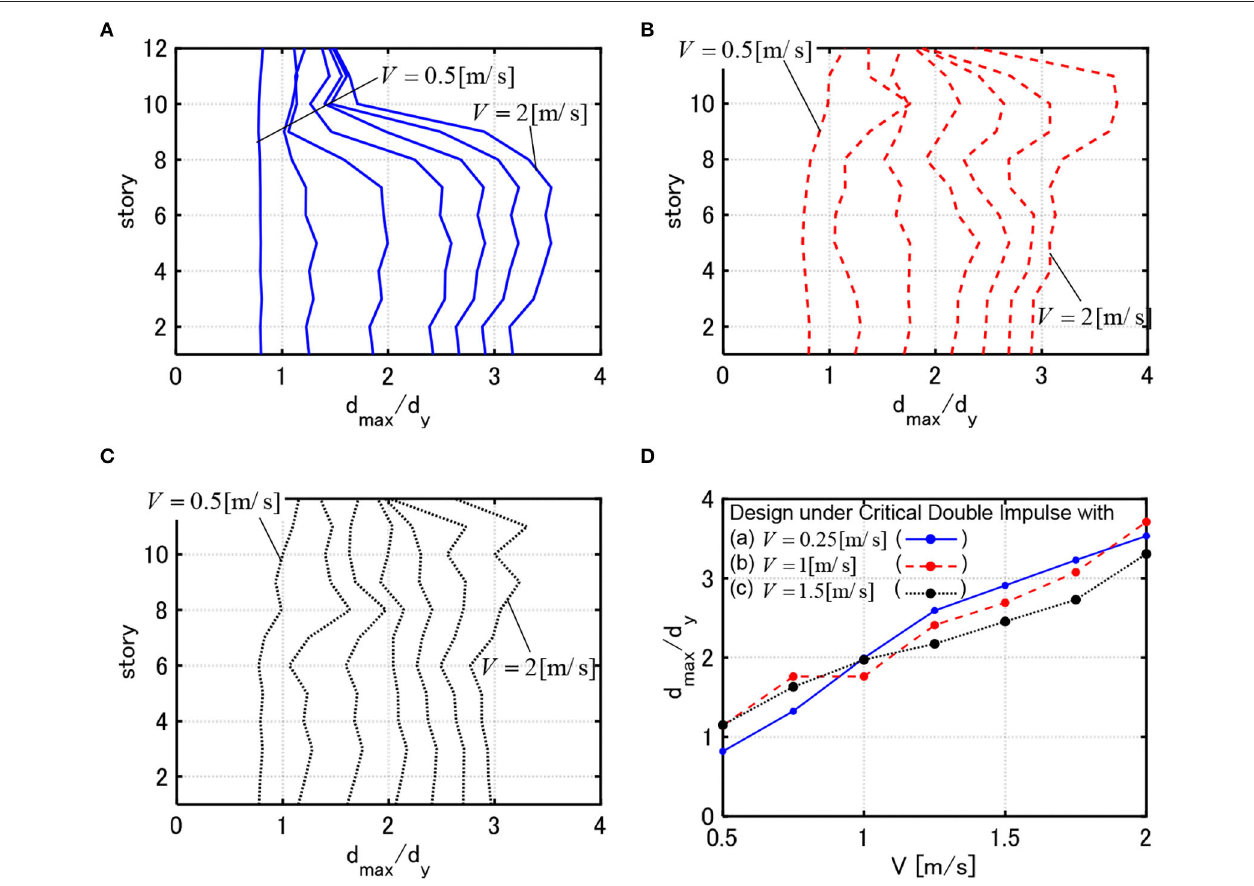
FIGURE 10 | DIP analysis for 3 models with W cF = 10 × 10 7 [ Ns / m ]. (A) Response of model designed under critical double impulse with V = 0.25[ m / s ]. (B) Response of model designed under critical double impulse with V = 1.0[ m / s ]. (C) Response of model designed under critical double impulse with V = 1.5[ m / s ]. (D) Comparison of maximum deformations for 3